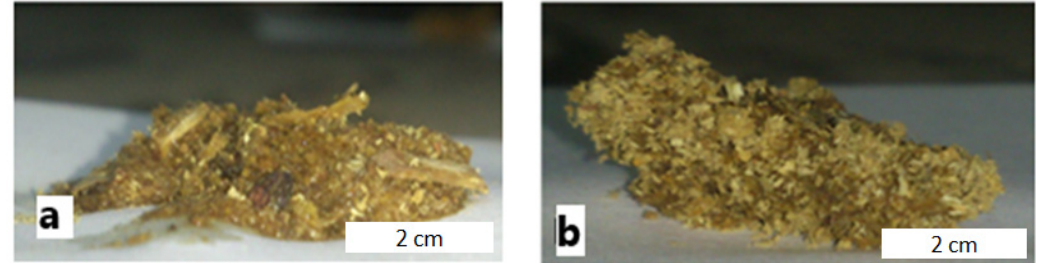
Figure 10. ( a ): Green pellet of Scots pine;10 ( b ): Green pellet of English oak.